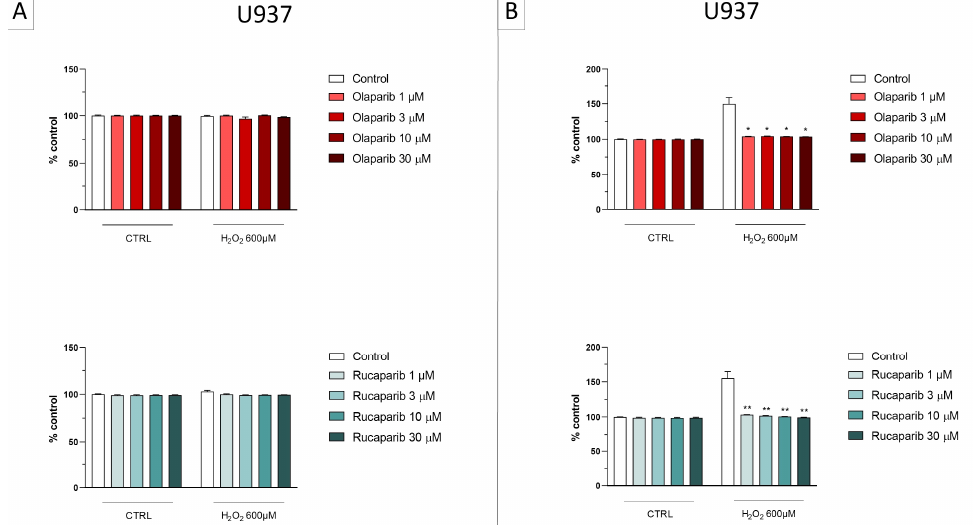
Figure 3. Effect of the clinical-stage PARP inhibitors olaparib or rucaparib on H 2 O 2 -induced cell necrosis in U937 cells. Cells were treated for 2 h ( A ) or 24 h ( B ) with 600 µM H 2 O 2 ; the PARP inhibitors were applied at different concentrations (1, 3, 10, and 30 µM). Cell necrosis was measured by measurement of LDH levels in the supernatant. * p < 0.05 and ** p < 0.01 indicate the beneficial effect of PARP inhibition to counteract the effect of oxidative stress. Data are shown as mean ± SEM of n = 5 independent experiments.